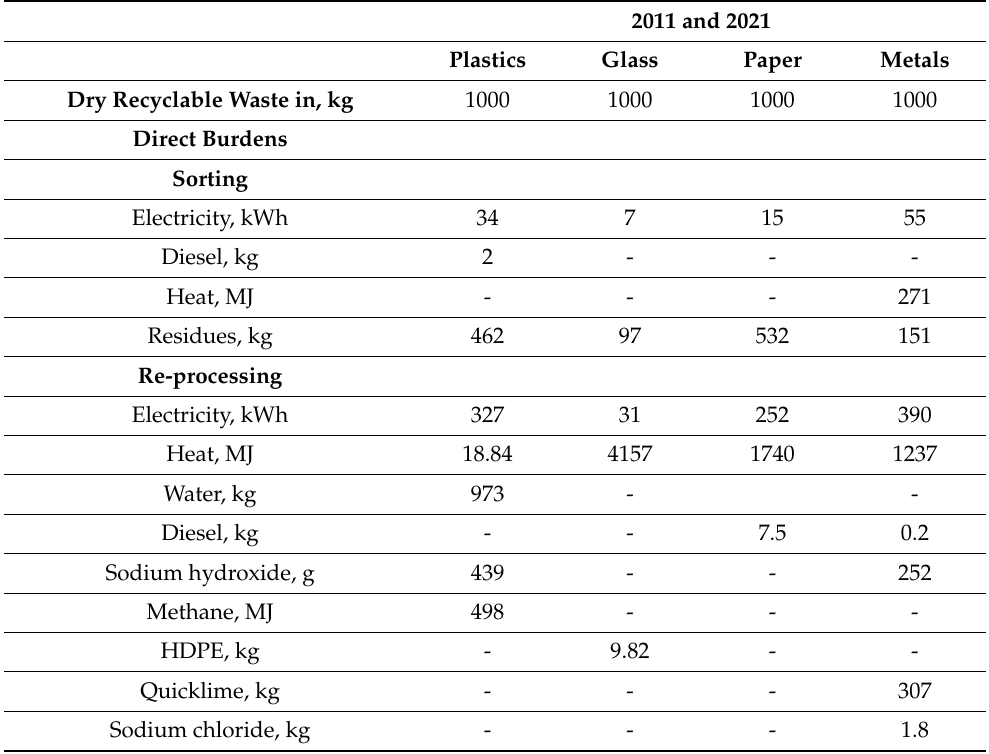
Table 2. Direct and avoided burdens related to management of separately collected dry recyclable waste. Data Source: